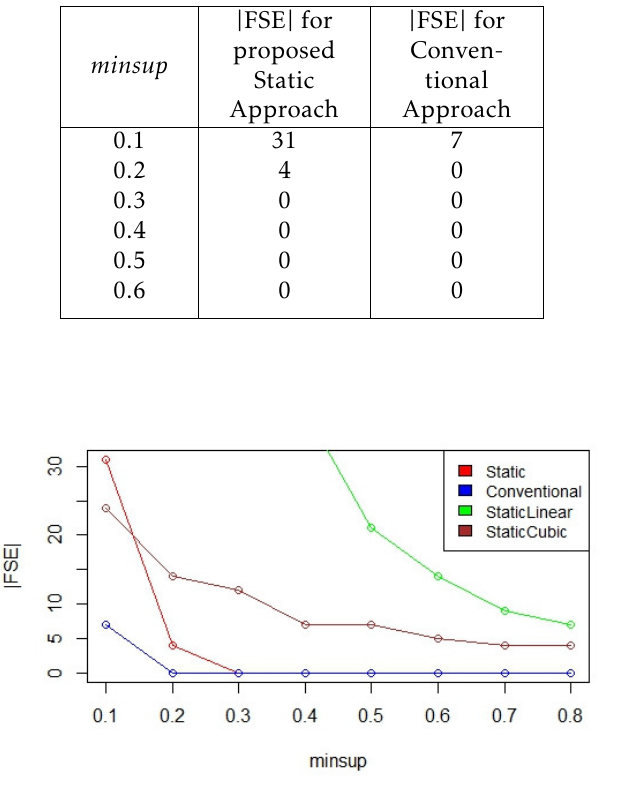
Figure 4. Number of frequent singleton edges ( | FSE | ) for proposed approaches with actual support using linear strategy and cubic strategy compared to conventional approach for sequence of paths